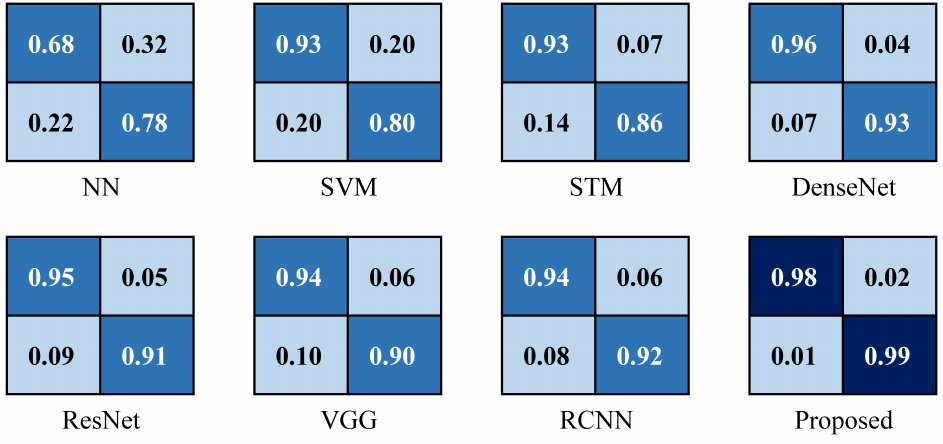
Figure 9. Confusion matrices of different